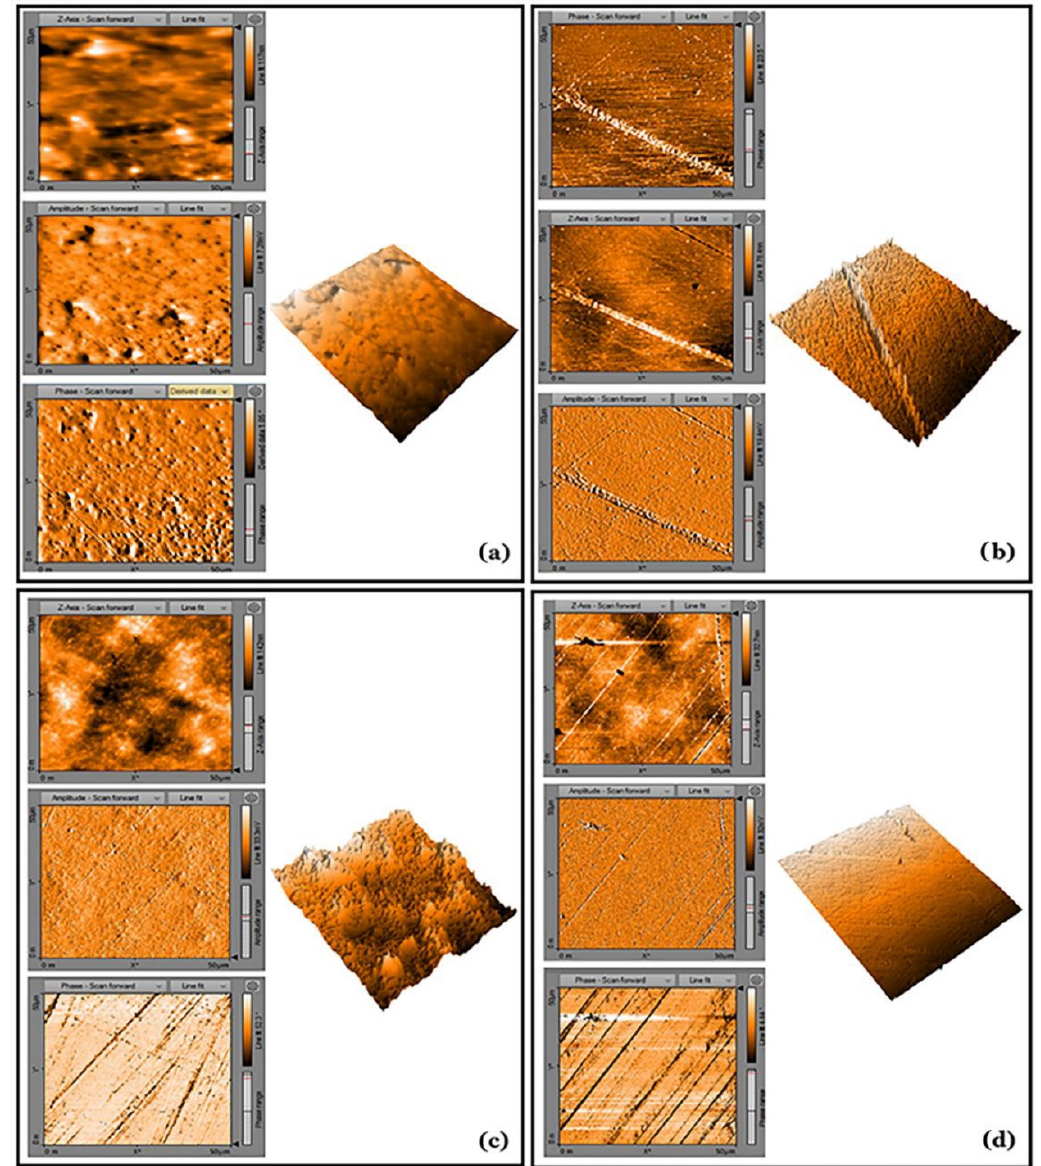
Figure 2. AFM photographs of the surface topography of the bulk fill CR samples: ( a ) Filtek™ Bulk Fill (3M™ ESPE, St. Paul, MN, USA, ( b ) Tetric EvoCeram ® Bulk Fill (Ivoclar Vivadent AG, Schaan, Liechtenstein), ( c ) SureFil ® SDR ® flow (Dentsply Sirona, Charlotte, NC, USA) and ( d ) Tetric EvoFlow ® Bulk Fill (Ivoclar Vivadent AG, Schaan, Liechtenstein).